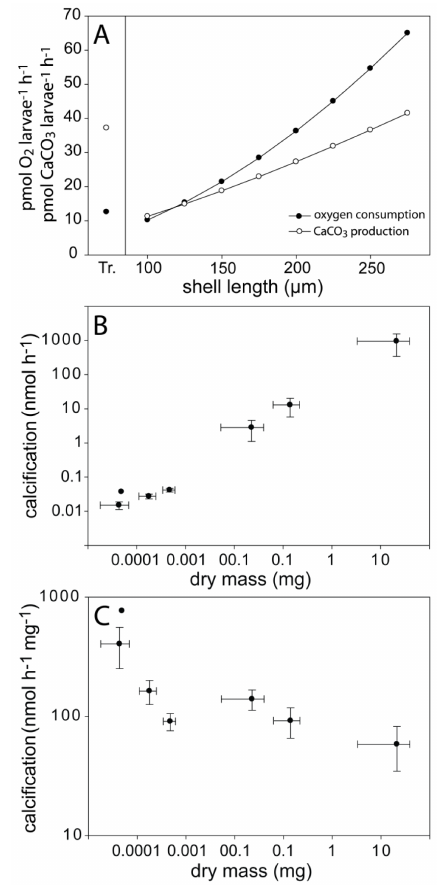
Figure 5. Changes of physiological rates during the ontogeny of M. edulis . (a) respiration and calcification rates during the planktonic larval phase, respiration data are taken from Sprung, 1984b; cal- cification rates are recalculated from Sprung, 1984a. (b) absolute calcification rates of larvae and juveniles (nmol h − 1 ) . (c) relative calcification rates (nmolh − 1 mg − 1 ) of larvae and juveniles. Data represent mean ±